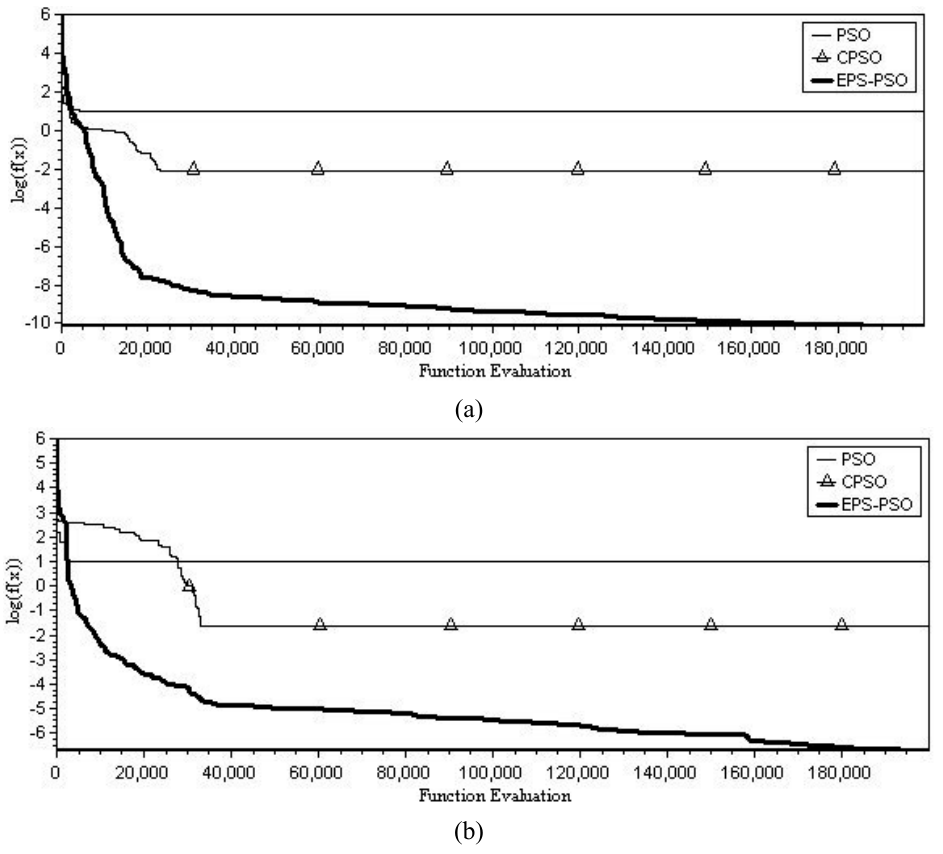
Figure 7. The best convergence results versus function evaluation among 50 independent runs for Griewank ( f 5 ): ( a ) unrotated case, ( b ) rotated case. Table 7. The performance comparisons between the proposed EPS-PSO algorithm and five di ff erent PSO variants over five benchmark